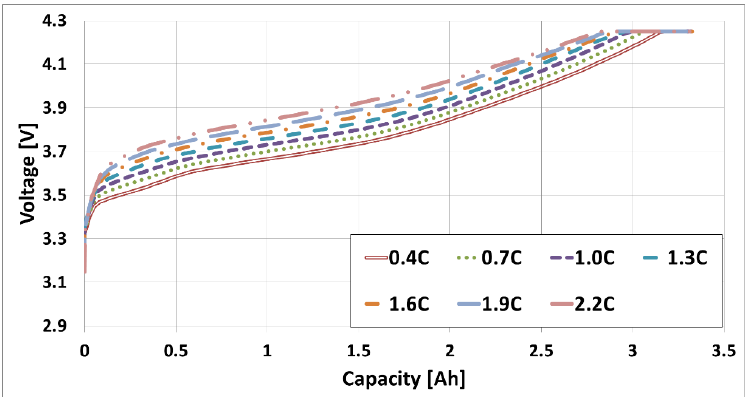
Figure 2. The current-voltage curve of the 3.3 Ah cell.